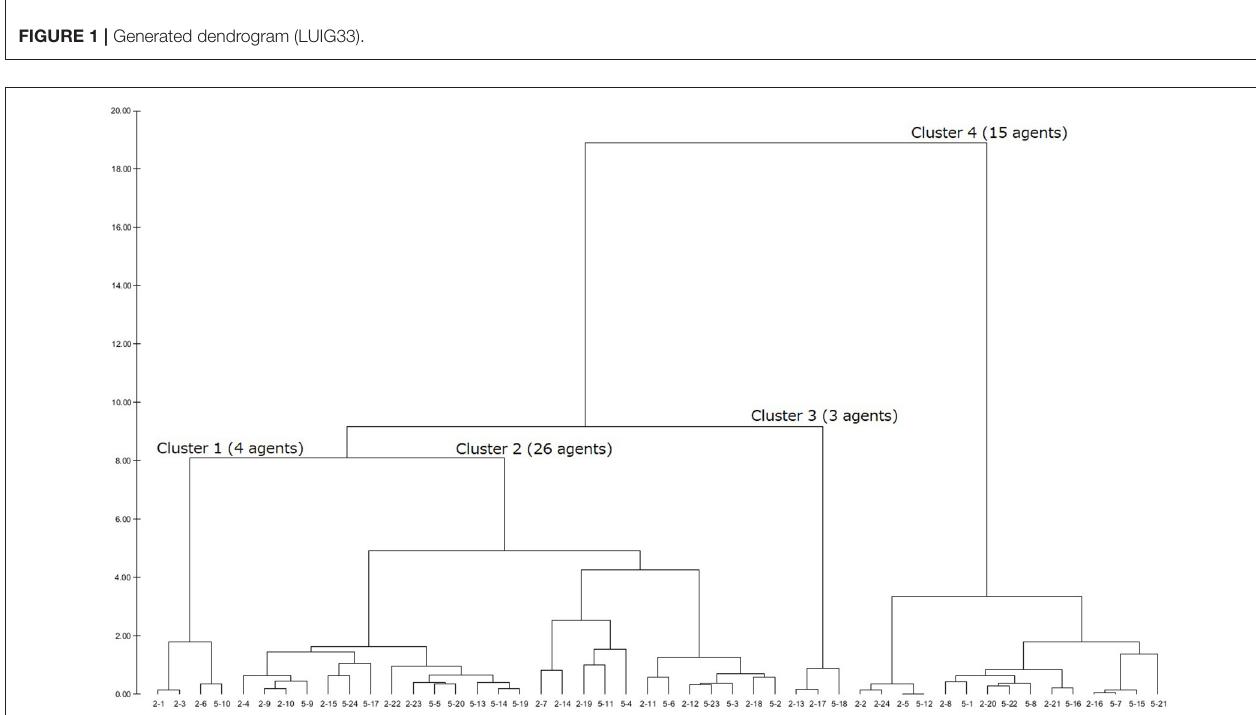
FIGURE 2 | Generated dendrogram (LUIG34).